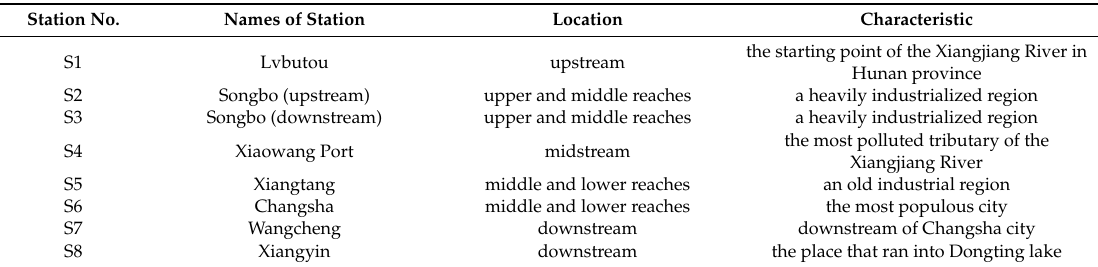
Table 1. Geographic background of the sampling stations of the Xiangjiang